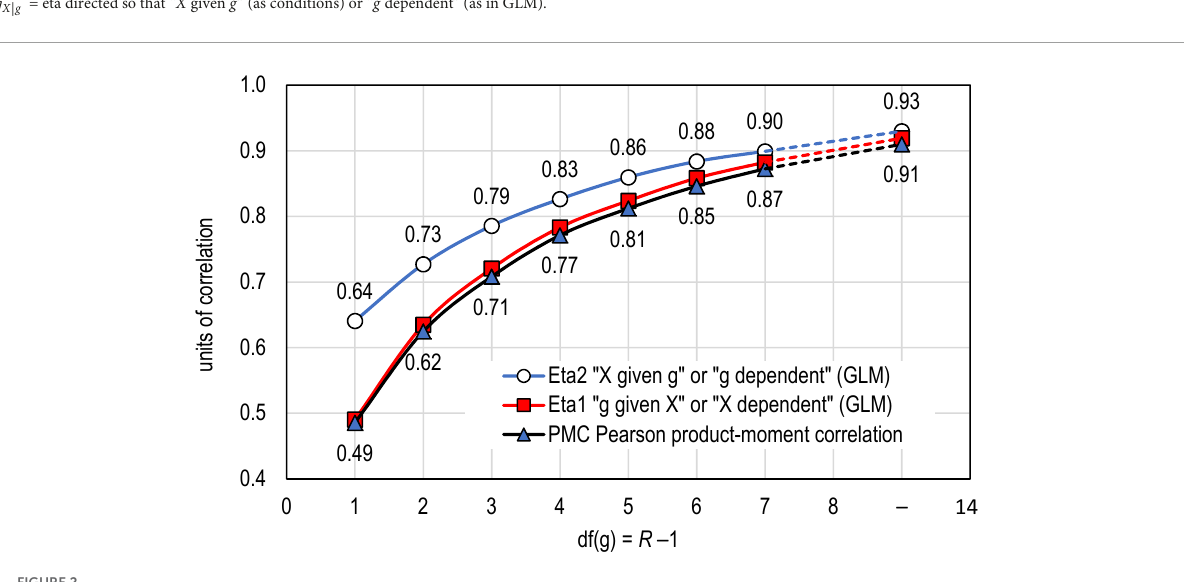
FIGURE2 Connection of PMC and eta in real-life datasets ( k = 11,160